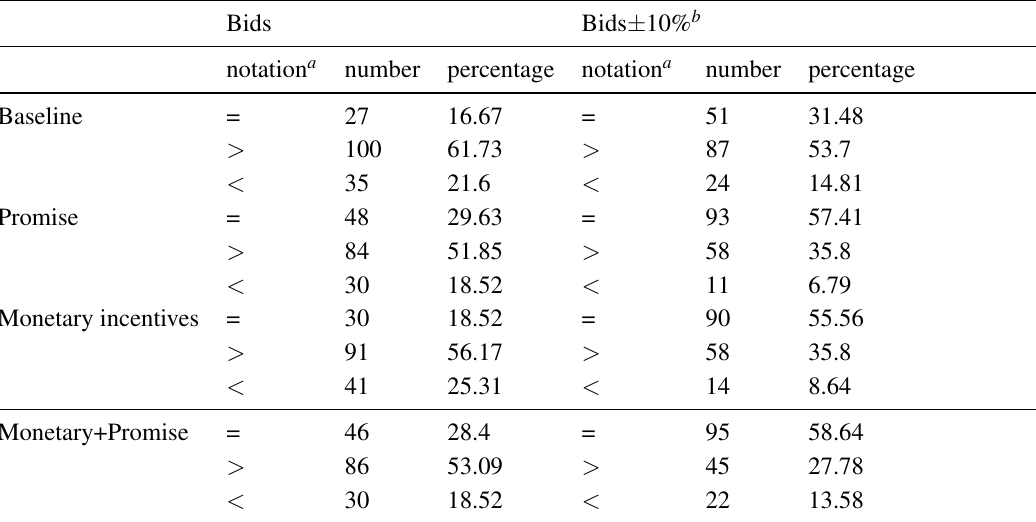
Table 5: Frequency of actual bids relative to private